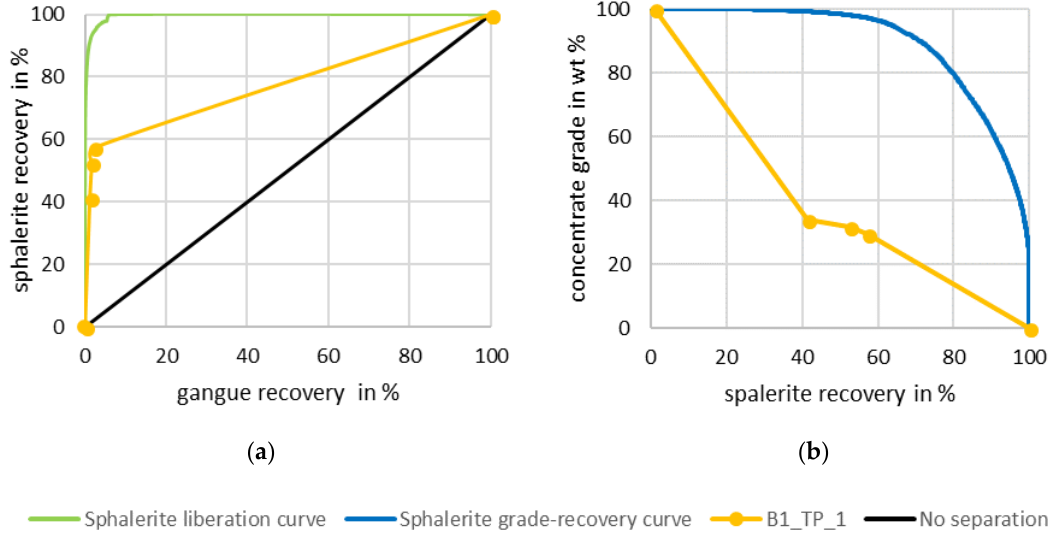
Figure 5. MLA-based Liberation curve ( a ) and grade-recovery curve ( b ) for B1_TP_1.